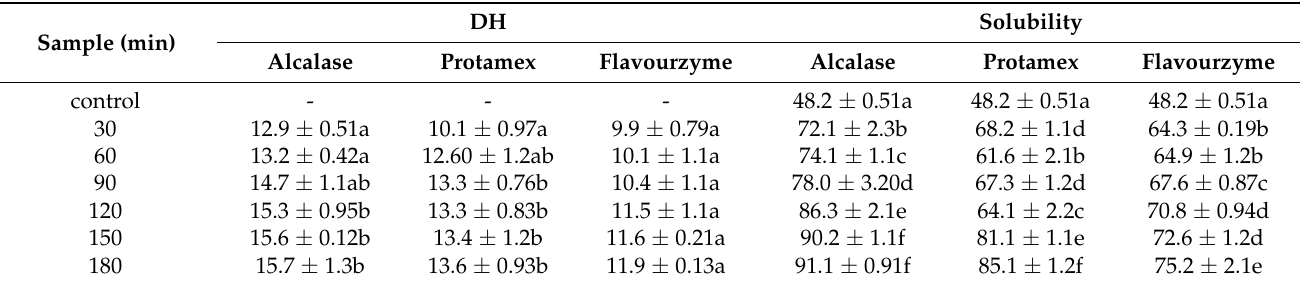
Table 1. Degree of hydrolysis and solubility of should be milk protein concentrate (MPC) hydrolysates by Alcalase, Flavourzyme, and